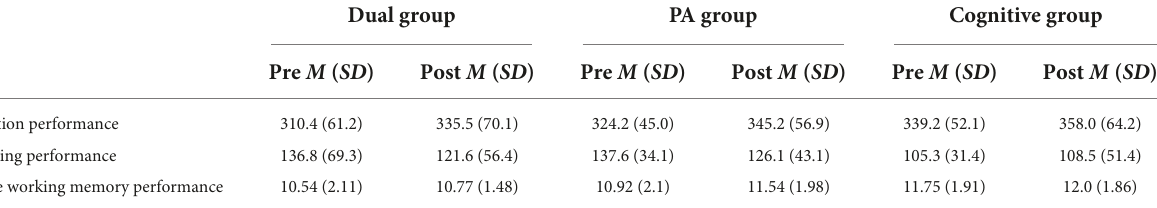
TABLE 4 Descriptive statistics of executive function